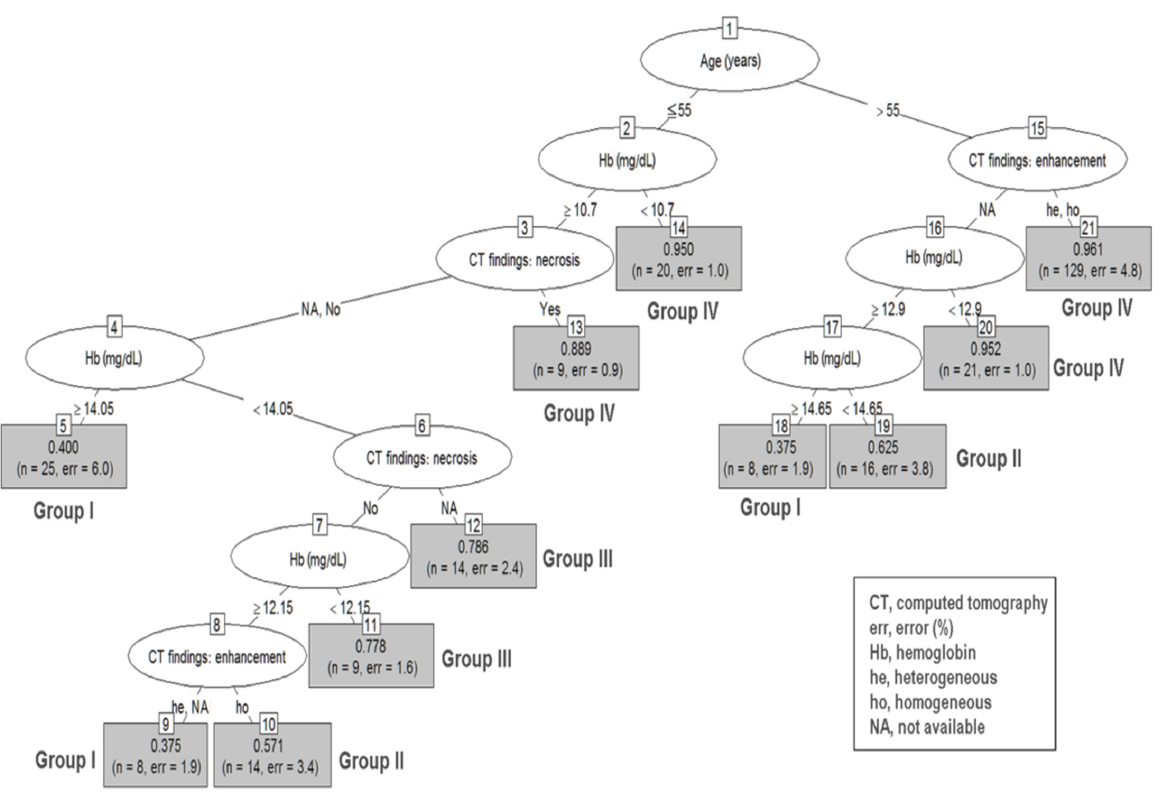
Figure 2. Recursive partitioning analysis of group 2–5 gastric subepithelial tumors. Decision tree constructed by recursive partitioning analysis in group 2–5 with 0.85 prediction accuracy. Terminal nodes are categorized into groups I to IV based on their prediction ability for gastrointestinal stromal tumors. Group I: nodes 5, 9, and 18 (0.375–0.400); group II: nodes 10 and 19 (0.571–0.625); group III: nodes 11 and 12 (0.778–0.786); group IV: nodes 13, 14, 20, and 21 (0.889–0.961).